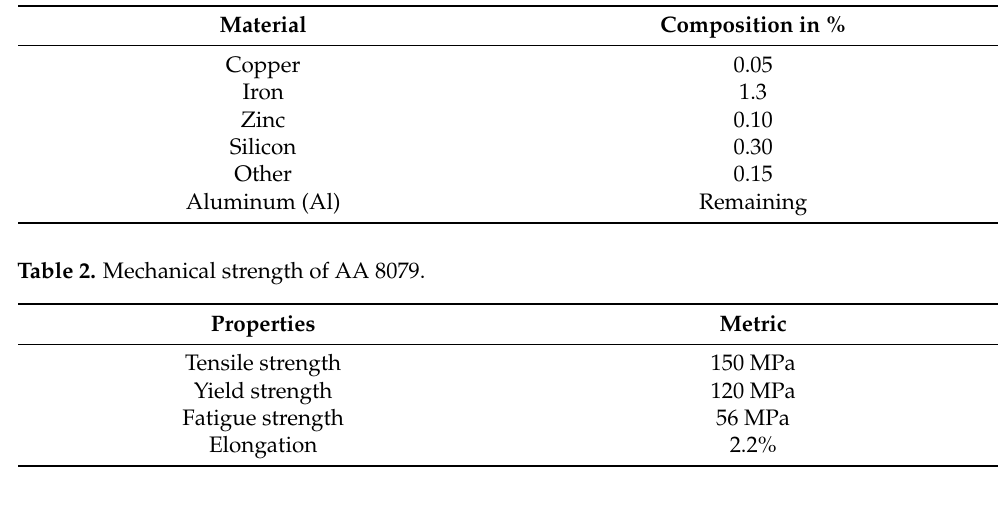
Table 1. Chemical constituent of AA 8079.